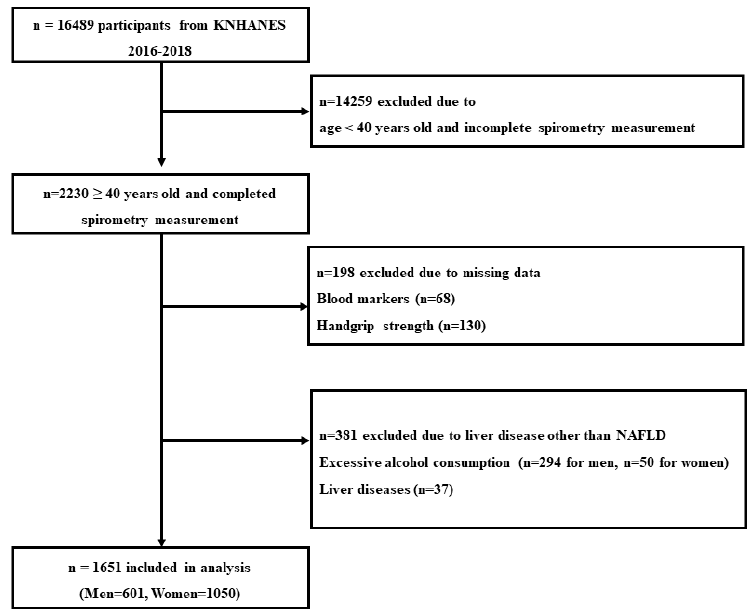
Figure 1. Flowchart of